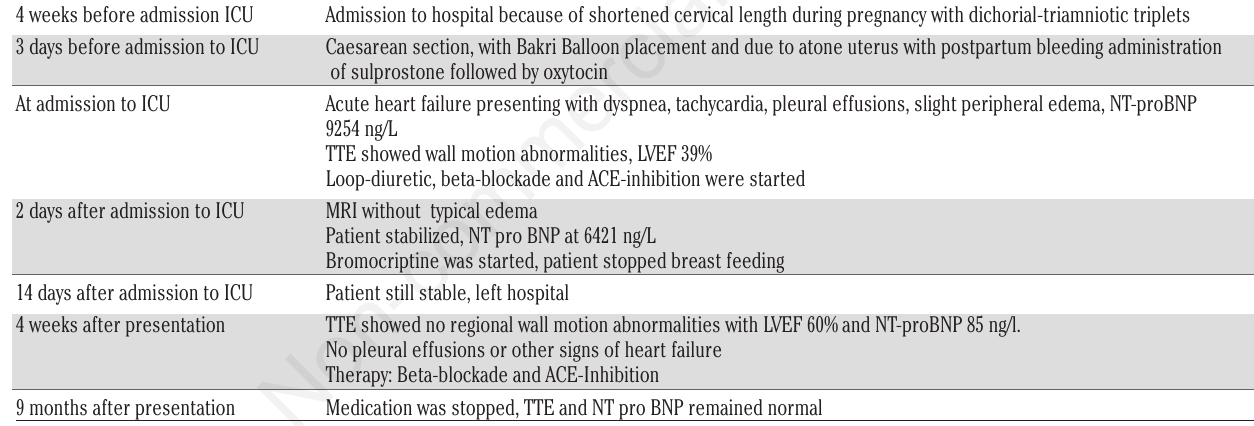
Table 1. Timeline.